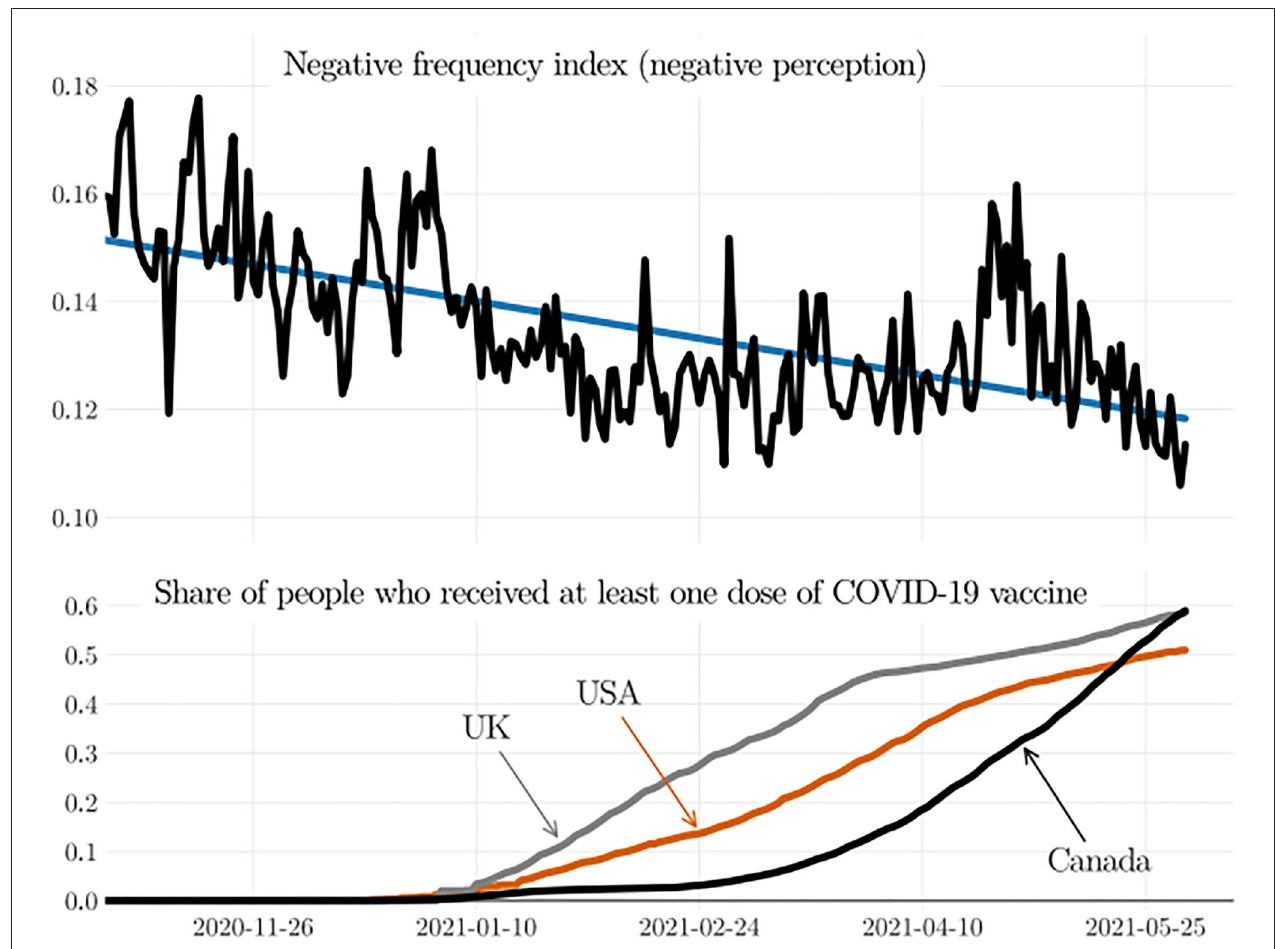
FIGURE 4 | Data from November 01, 2020, to June 01, 2021: negative frequency index (negative perception in tweets) and share of the population in the USA, the UK, and Canada who received at least one dose of the COVID-19 vaccine. The straight line (in blue, upper curve), obtained by linear regression, indicates that the negative perception decreased intensively right after the vaccination in these three countries